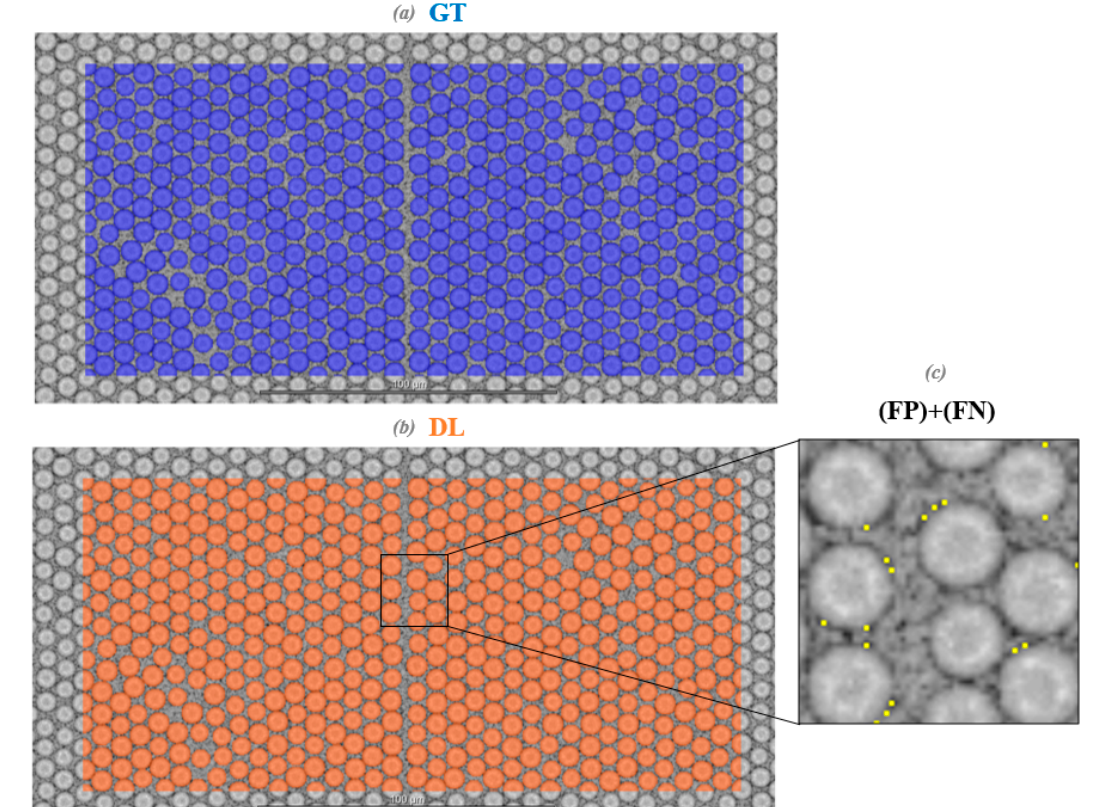
Figure 5. Superposition of synthetic image with ( a ) ground-truth segmentation (GT, blue) and ( b ) deep learning segmentation (DL, orange). Locations of false positives (FP) and false negatives (FN) are indicated by yellow pixels in ( c ).